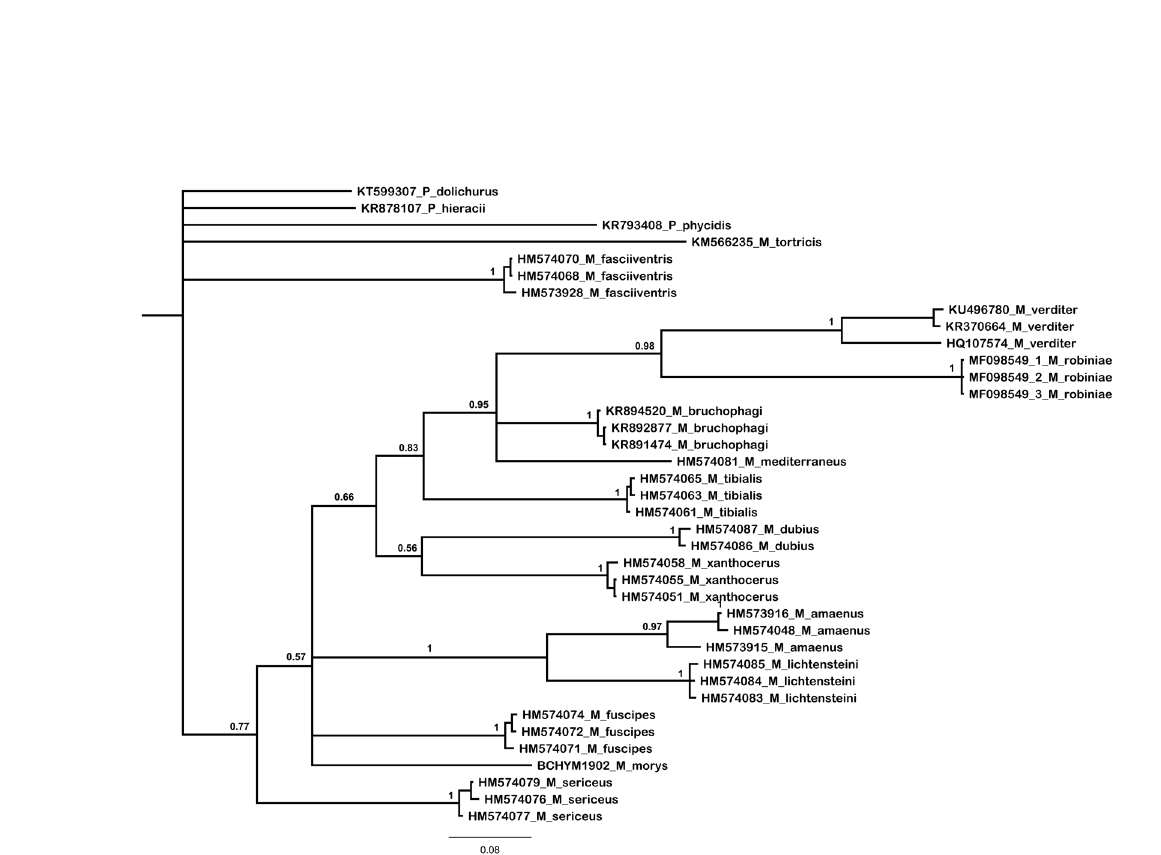
Fig. 4. Bayesian inference (BI) tree of the species of Mesopolobus Westwood, 1833 that have available mitochondrial COI sequences. Numbers on the branches represent posterior probabilities